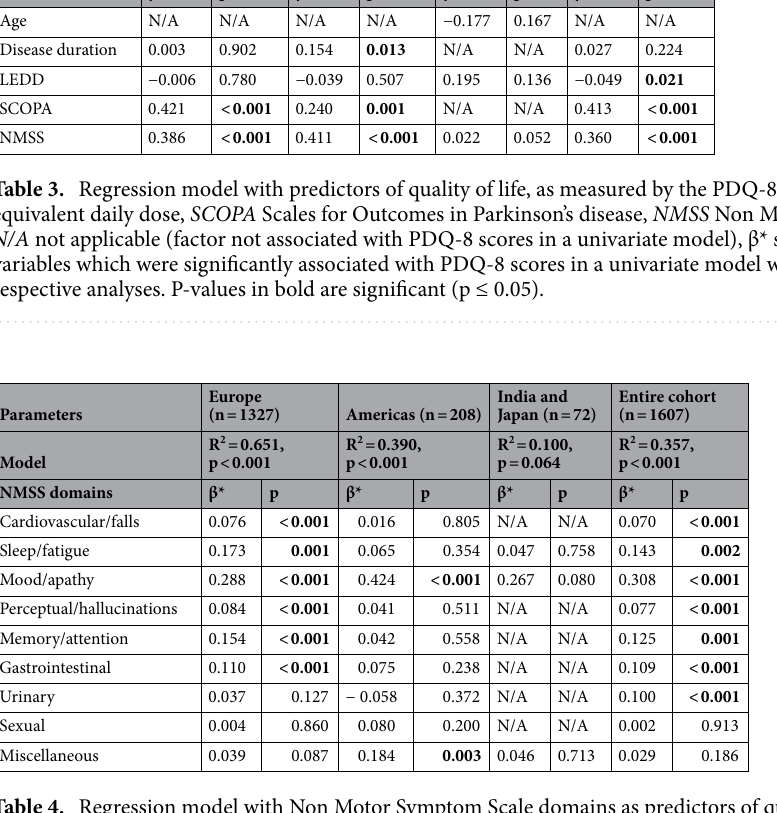
Table 4. Regression model with Non Motor Symptom Scale domains as predictors of quality of life (measured by the PDQ-8 scale). NMSS Non Motor Symptoms Scale, N/A not applicable (factor not associated with PDQ-8 scores in a univariate model); β* standardised β. Only domains which were significantly associated with PDQ-8 scores in a univariate model were included in the respective analyses. P-values in bold are significant (p ≤